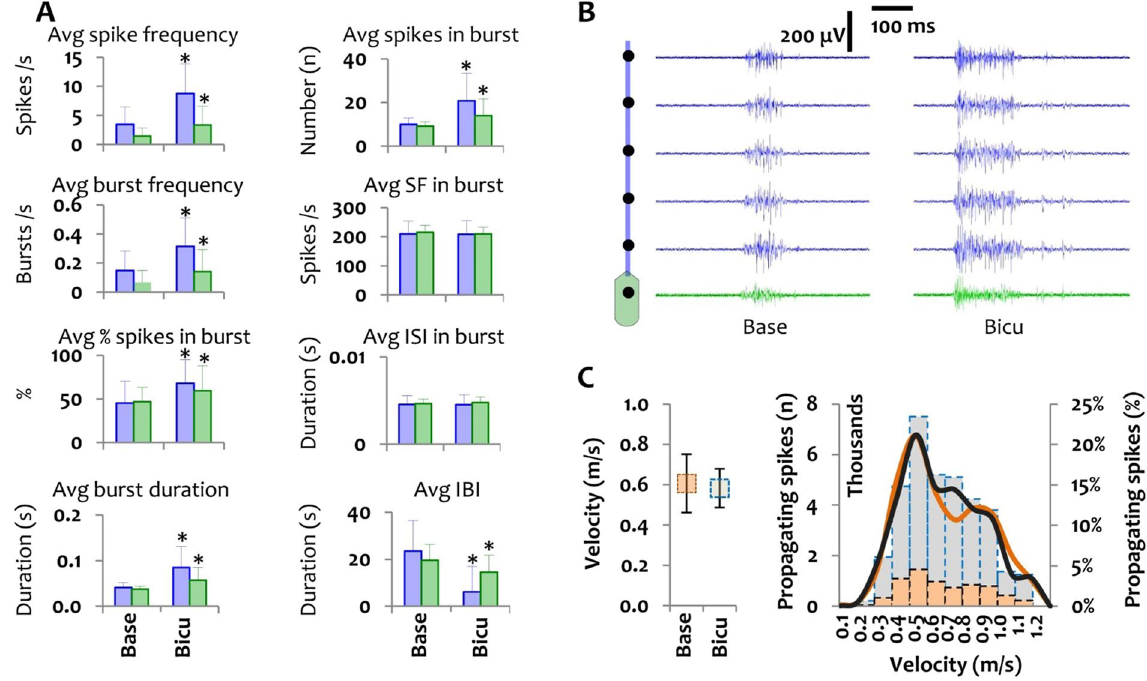
Figure 6. The effect of bicuculline on activity features and propagation velocity. ( A ) The effect of bicuculline on the overall activity in the soma (green bars) and axon (blue bars) expressed as mean spike frequency, mean burst frequency, mean percentage of spikes in a burst (%), mean burst duration, average number of spikes per burst, mean spike frequency (SF) in a burst, mean inter-spike interval (ISI) in a burst and mean inter-burst interval (IBI). Data are represented as the mean ± StDev of the baseline activity or after bicuculline treatment in four cortical cultures including 153 microchannel electrodes (blue bars and signals) and 56 reservoir electrodes (green bars and signals). ( B ) Exemplary recording profile of one network module including reservoir (green signals) and axons (blue signals) at baseline and after bicuculline treatment. ( C ) Propagation velocity in bicuculline-treated cortical cultures (n = 4) at 24 and 25 DIVs. Left graph: average propagation velocity at baseline and after bicuculline treatment (n = 32 microchannels). Right graph: effect of bicuculline treatment on the number (gray bars) and percentage (dark line) of propagating spikes in each velocity domain. The percentage of propagating spikes in each velocity domain at baseline (orange line) or after treatment with bicuculline (dark line) was calculated by dividing the number of propagating spikes in each velocity domain by the total number of propagating spikes in all velocity domains. Avg: average, Base: baseline, Bicu: